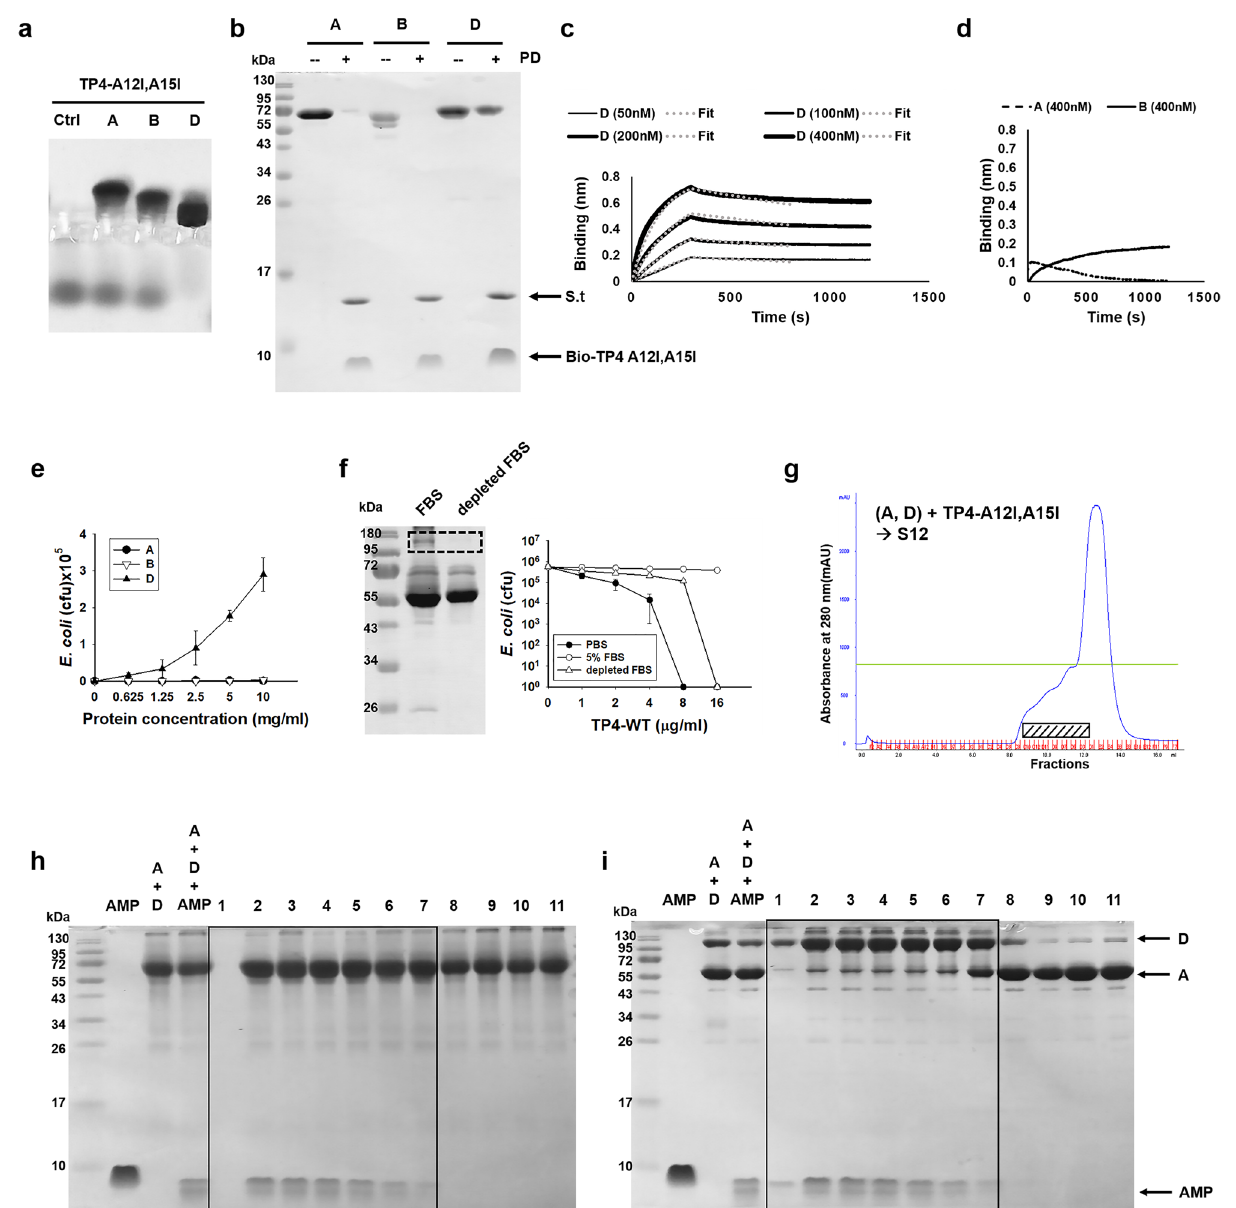
Figure 3. Binding of purified proteins to TP4-A12I,A15I. ( a ) Band shift of TP4-A12I,A15I by proteins A, B and D analyzed by 8% horizontal native PAGE and Coomassie blue staining. ( b ) Pulling down of proteins A, B and D by biotinylated TP4-TP4A12I,A15I immobilized on Streptavidin-conjugated beads. ( c , d ) Biolayer interferometry analysis of protein A, B, and D. The protein D showed potent and reversible binding to biotinylated TP4-A12I,A15I ( c ), but no substantial binding was observed in protein A and B ( d ). Heavy lines represent the experimental data, dotted lines represent the global-fitted data for analysis. ( e ) Inhibition of bactericidal activity of TP4 to E. coli (10 6 cfu/ml) by protein D not by protein A or B. ( f ) Decrease of inhibitory effect of FBS on TP4 ′ s antimicrobial activity by the depletion of protein D with TP4-A12I,A15I immobilized beads. ( g ) FPLC S12 gel filtration chromatography of proteins A/D mixture in the presence of TP4-A12I,A15I. ( h , i ) Analysis of column eluates as shown in figure g by 15% reduced ( h ) and non-reducing ( i ) SDS-PAGE. TP4-A12I,A15I-containing fractions are shown in Binding site of AMP and drug in protein D. The blue shift of fluorescence emission spectrum of protein D was observed following the addition of TP4-A12I,A15I or antipyretic agent ibuprofen, but these reagents did not cause blue shift in protein A (albumin) 13 . As a positive control, the anionic surfactant, sarkosyl, caused blue shifts for both protein A and protein D (Fig. 7a). In contrast, no blue shift was seen in protein A and protein D by the anticonvulsant phenytoin which is weekly bound by albumin 14 . Furthermore, only protein D, but not protein A, was bound by TP4-A12I,A15I analyzed by band-shifted assay. Interestingly, the binding of protein D